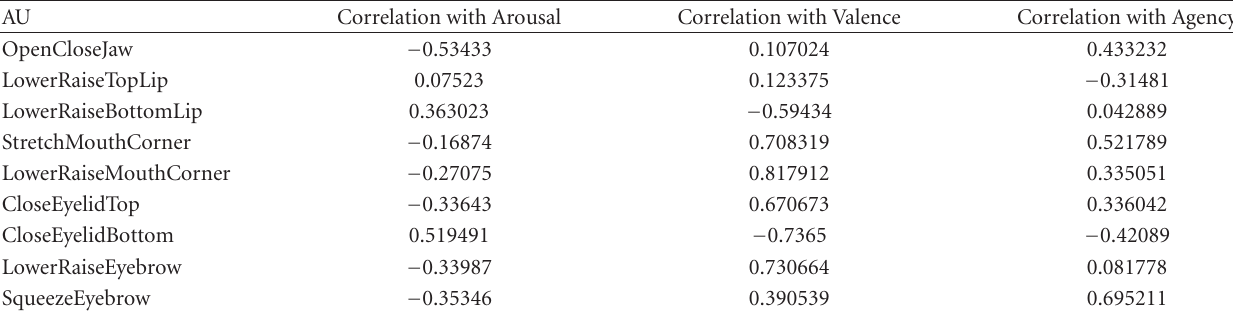
Table 5: Correlation between emotion parameters and facial actions. Values between − 1 and +1. Zero means no correlation.